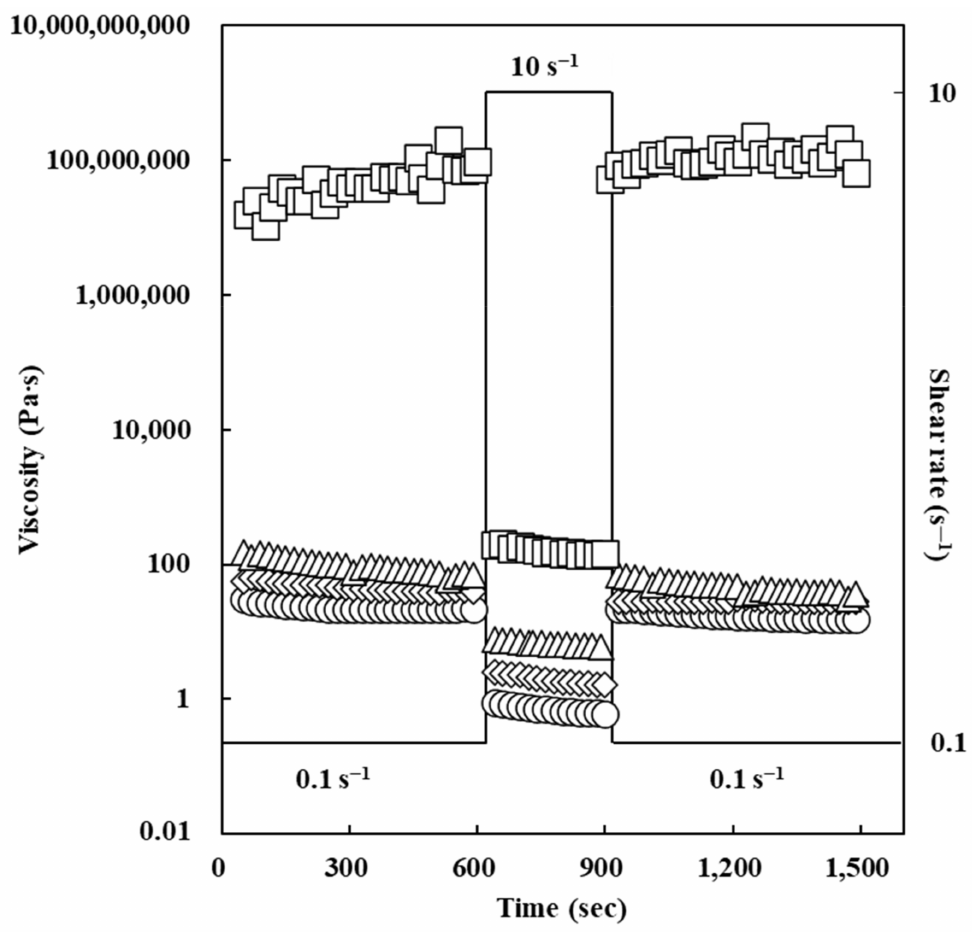
Figure 4. Time-dependent behavior of oleogels prepared with different concentrations of esterified rice flour with citric acid (ERCA). ( ) Oleogel prepared with 0% ERCA, ( ) Oleogel prepared with (cid:35) (cid:51) 5% ERCA, ( ∆ ) Oleogel prepared with 10% ERCA, and ( (cid:3) ) Oleogel prepared with 15%